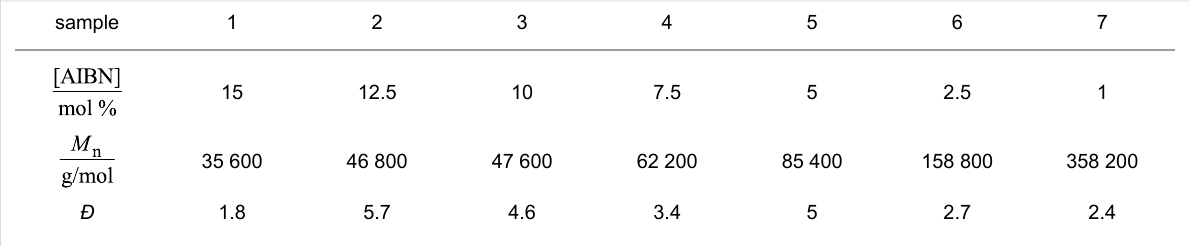
Table 1: SEC data from the polymerization of MLA with different amounts of AIBN ( c (MLA) = 1.812 mol L − 1 in 1,4-dioxane, 15–1 mol % AIBN, 70 °C, polymerization time 2 minutes). sample